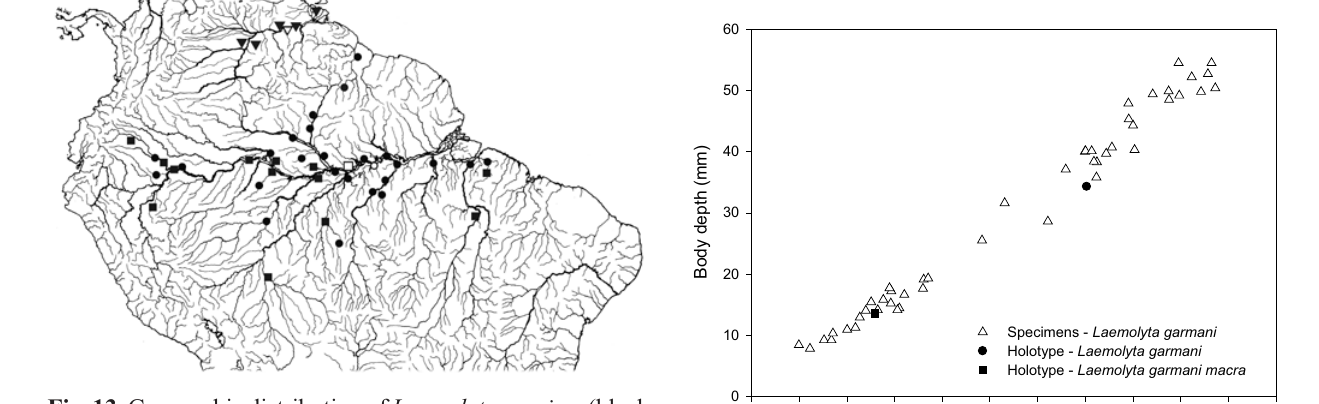
Fig. 13. Geographic distribution of Laemolyta proxima (black dots; open circle = type-locality), Laemolyta garmani (black squares; open squares = type-locality), and Laemolyta orinocensis (black triangles; open triangle = type-locality). Some symbols might correspond to more than one locality.